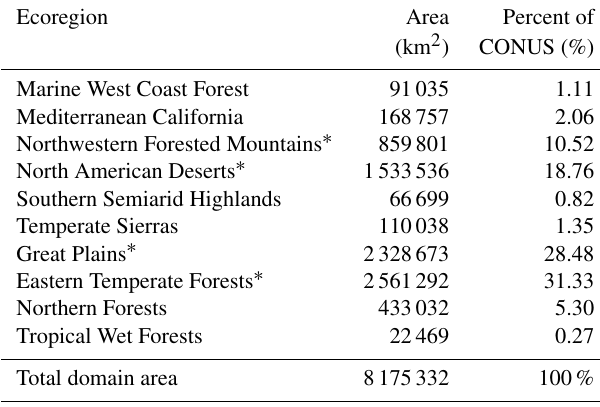
Table 2. Sizes of study ecoregions in square kilometers (km 2 ) and percent (%) of study